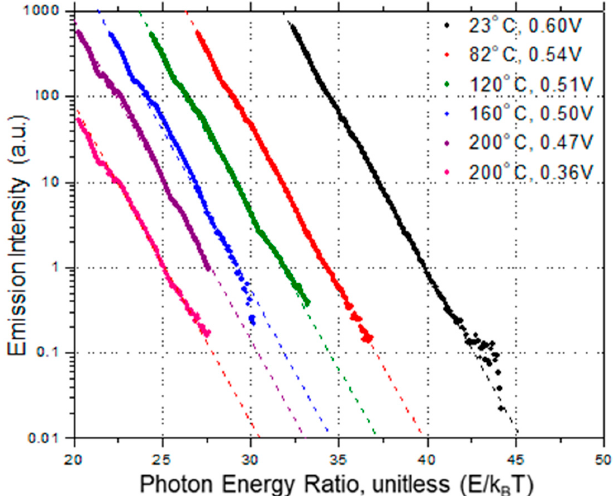
Figure 6. Intensity versus Photon Energy Ratio at Various Temperatures and Biases. These are the same runs as in Figure 5, plotted with the log of the intensity versus the calculated ratio of photon energy to lattice thermal energy.